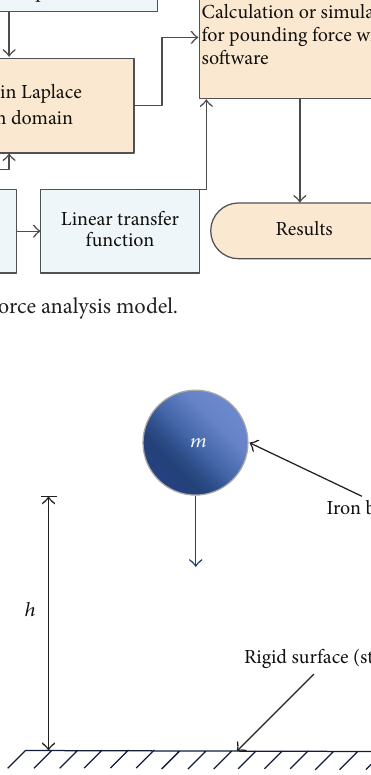
Figure 5: Model of a ball falling on a stationary rigid surface